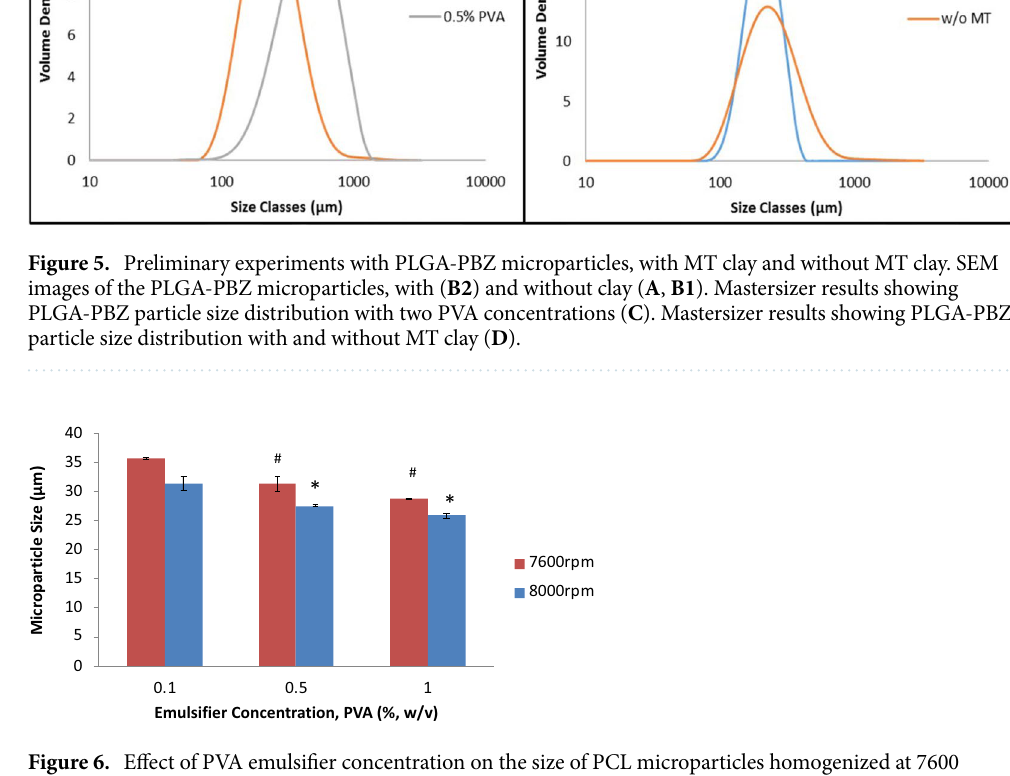
for two seasons. Values of RGB variation were extracted from unmanned aerial vehicle (UAV) photos which were taken during the winter season in the first year and second year of the field experiment (Supplementary